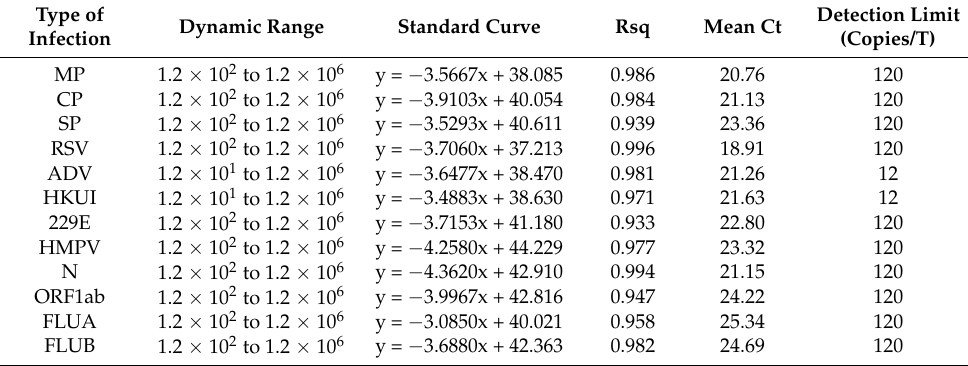
Table 4. Summary of sensitivity of on-chip